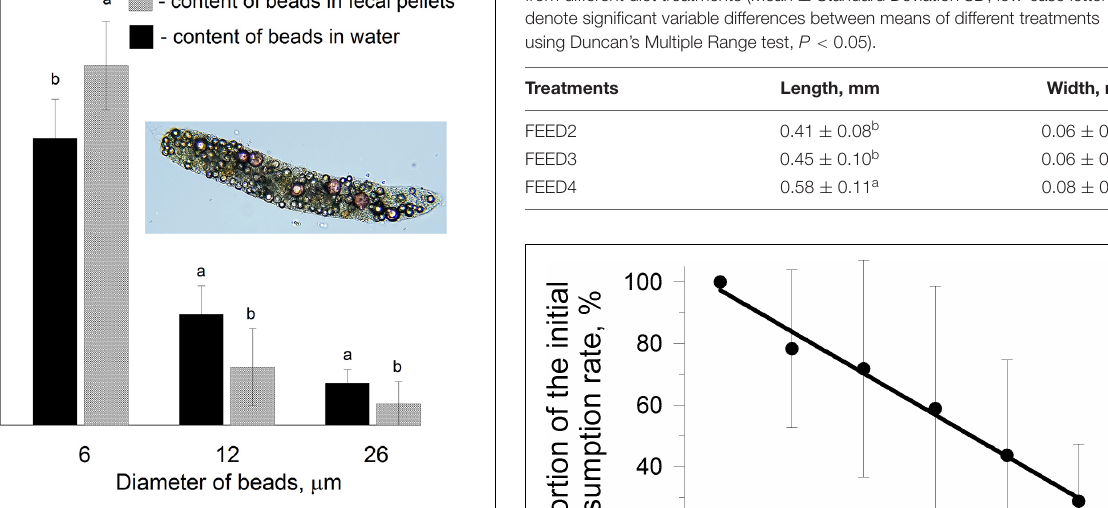
FIGURE 3 | Percentage share of different sized microplastic beads (6, 12, and 26 µ m) in water and fecal pellets of Calanus helgolandicus on 3 day of incubation (microplastics and mixed phytoplankton were offered as food in equal concentrations ( ∼ 5,000 cells ml − 1 ). Low-case letters (a,b) are the significant variable differences from Duncan’s Multiple Range test (DMRT), P < 0.05.